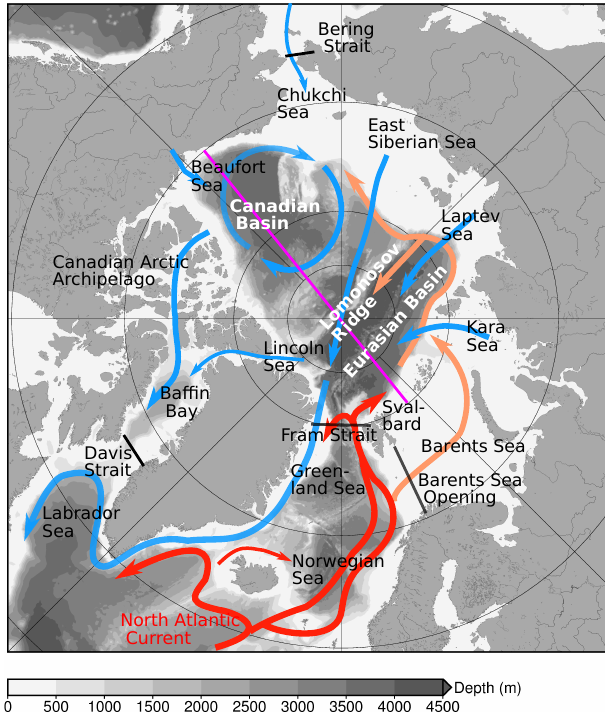
Figure 1. Schematic of main ocean circulations in the pan-Arctic Ocean. The freshwater circulation is shown with light blue arrows, and the Atlantic Water (AW) circulation is shown with red/orange arrows. The gray patch in the background shows the ocean bottom bathymetry. The black lines indicate the four Arctic gateways. The magenta line crossing the North Pole indicates the location of the transect shown in Fig. 8e,